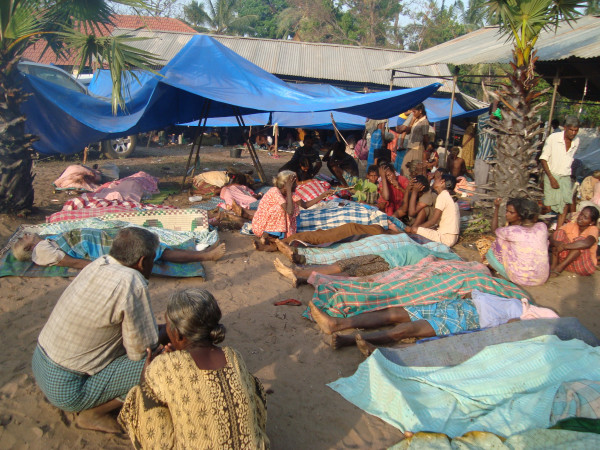
Ubiquitous death.